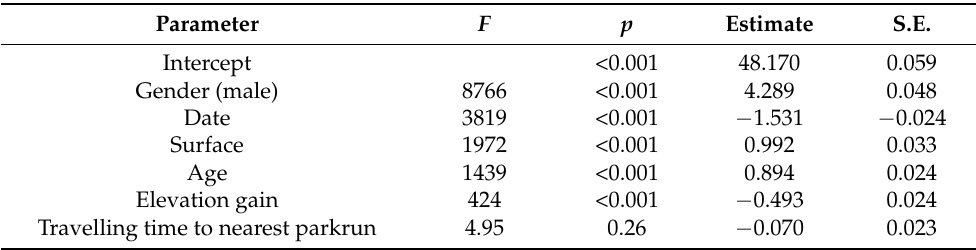
Table 5. A linear mixed model of the AGPS of first timers at Scottish parkrun events. Event venue was included as a random effect.